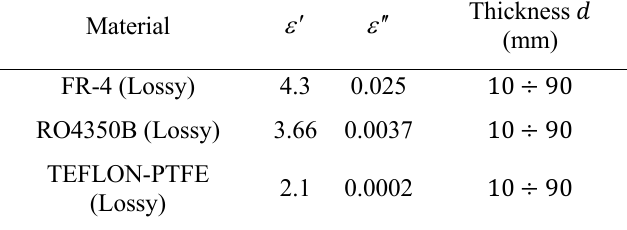
Table 1: The parameters of material